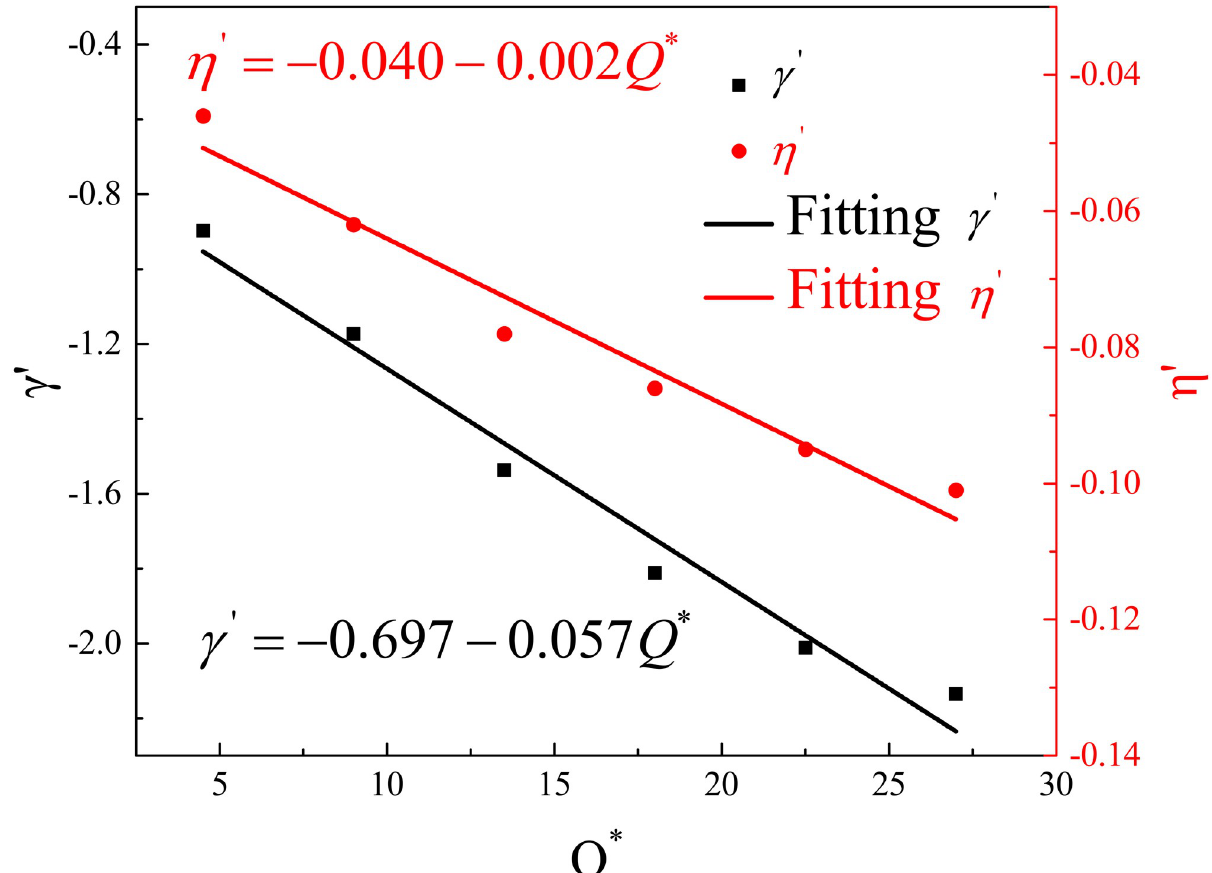
Fig 14. The fitting coefficients of γ 0 and η 0 against dimensionless heat release rate Q �